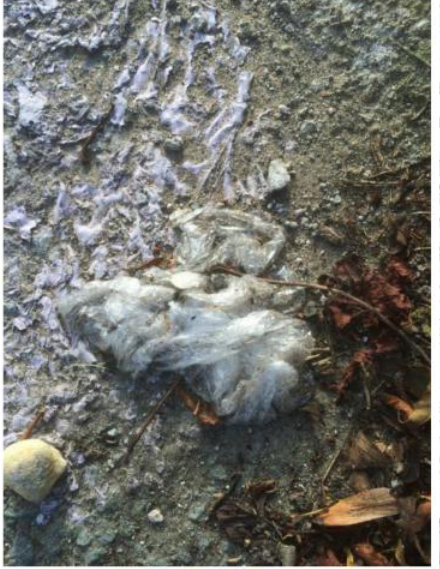
Figure 5. Clingfilm on Car Park